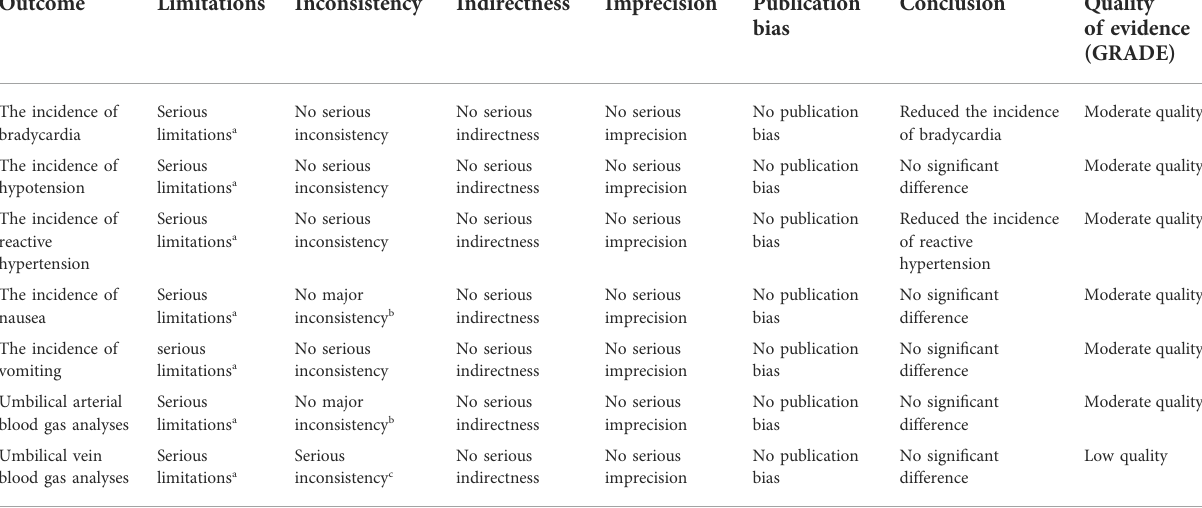
TABLE 2 Levels of evidence for outcome